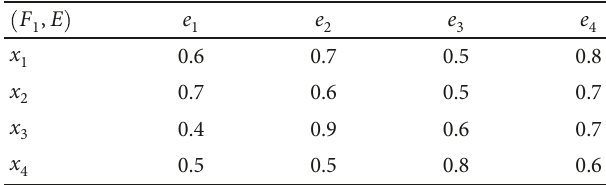
Table 11: The evaluation value of expert 1.